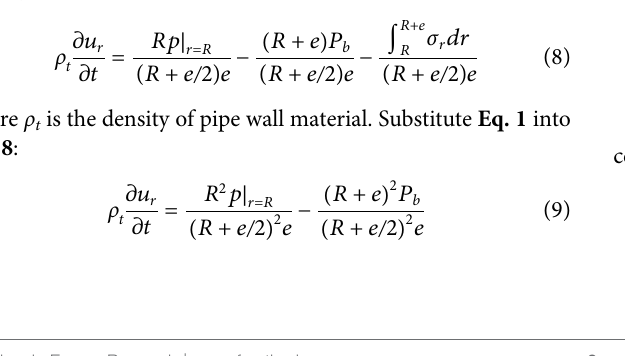
Frontiers in Energy Research |